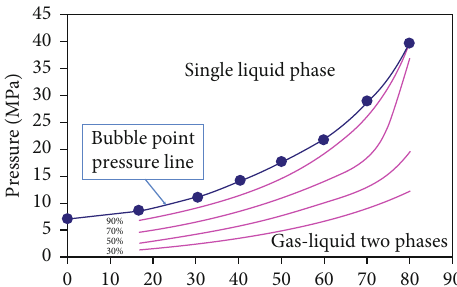
Figure 1: P-X phase diagram of CO